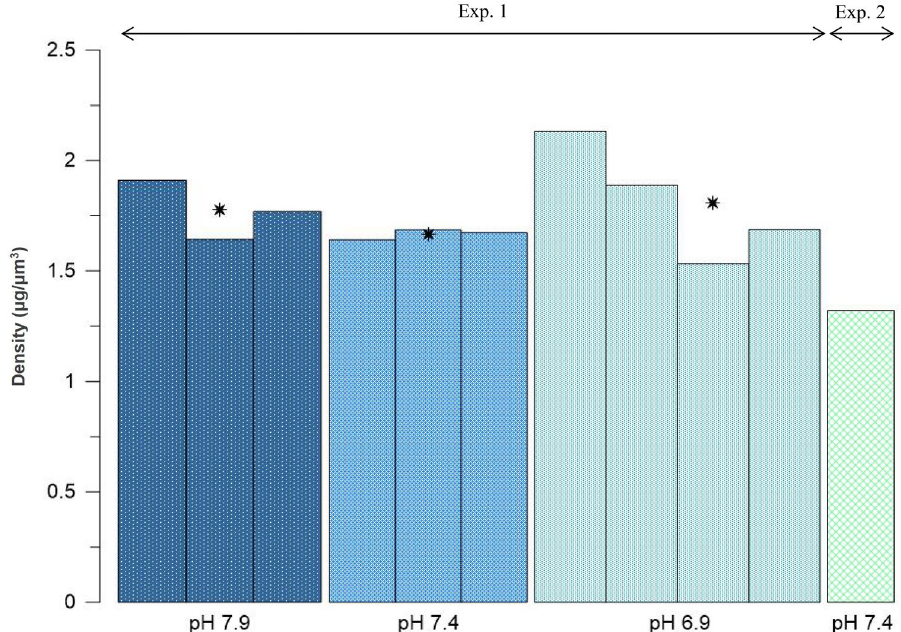
Figure 3. Test density of Peneroplis spp. specimens after 3 days at pH 7.9, 7.4 and 6.9 (Exp. 1), and after 32 days at pH 7.4 (Exp. 2). Each bar corresponds to one specimen. Stars (*) show the mean value for each pH condition.